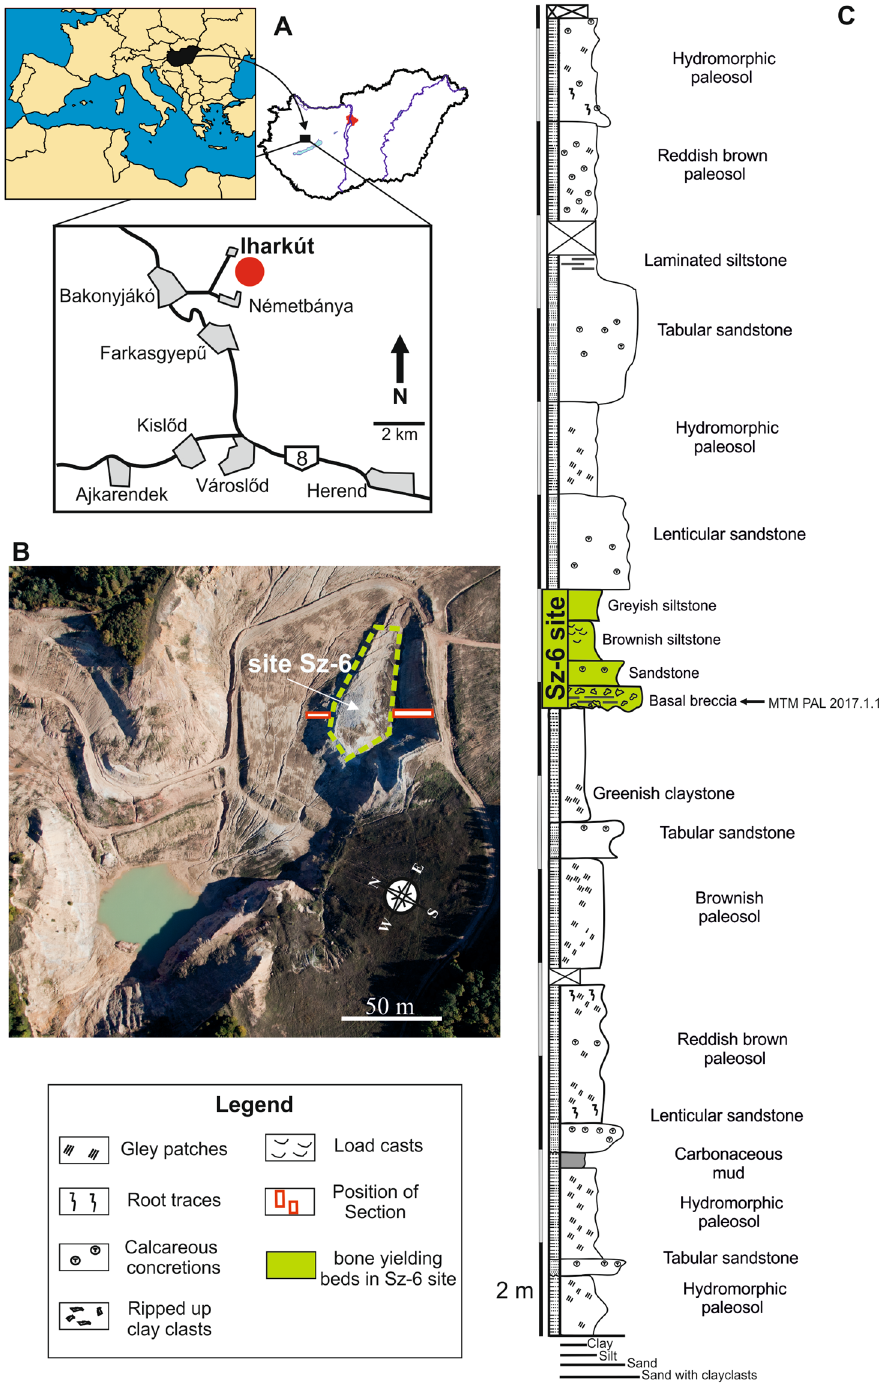
Figure 1. The Santonian Iharkút vertebrate locality (Hungary), and the geological background of site SZ-6. ( A ) Location map of the Iharkút vertebrate locality. (Maps were created by AŐ with Corel Draw 12, http://www. coreldraw.com/en/pages/coreldraw-12/) ( B ), Aerial photo of the Iharkút open-pit, showing the position of site SZ-6. (Photo was taken by Péter Somogyi-Tóth) ( C ), Stratigraphic section of the Csehbánya Formation exposed in the open-pit with site SZ-6 highlighted by green (modified after Botfalvai et al .) 21